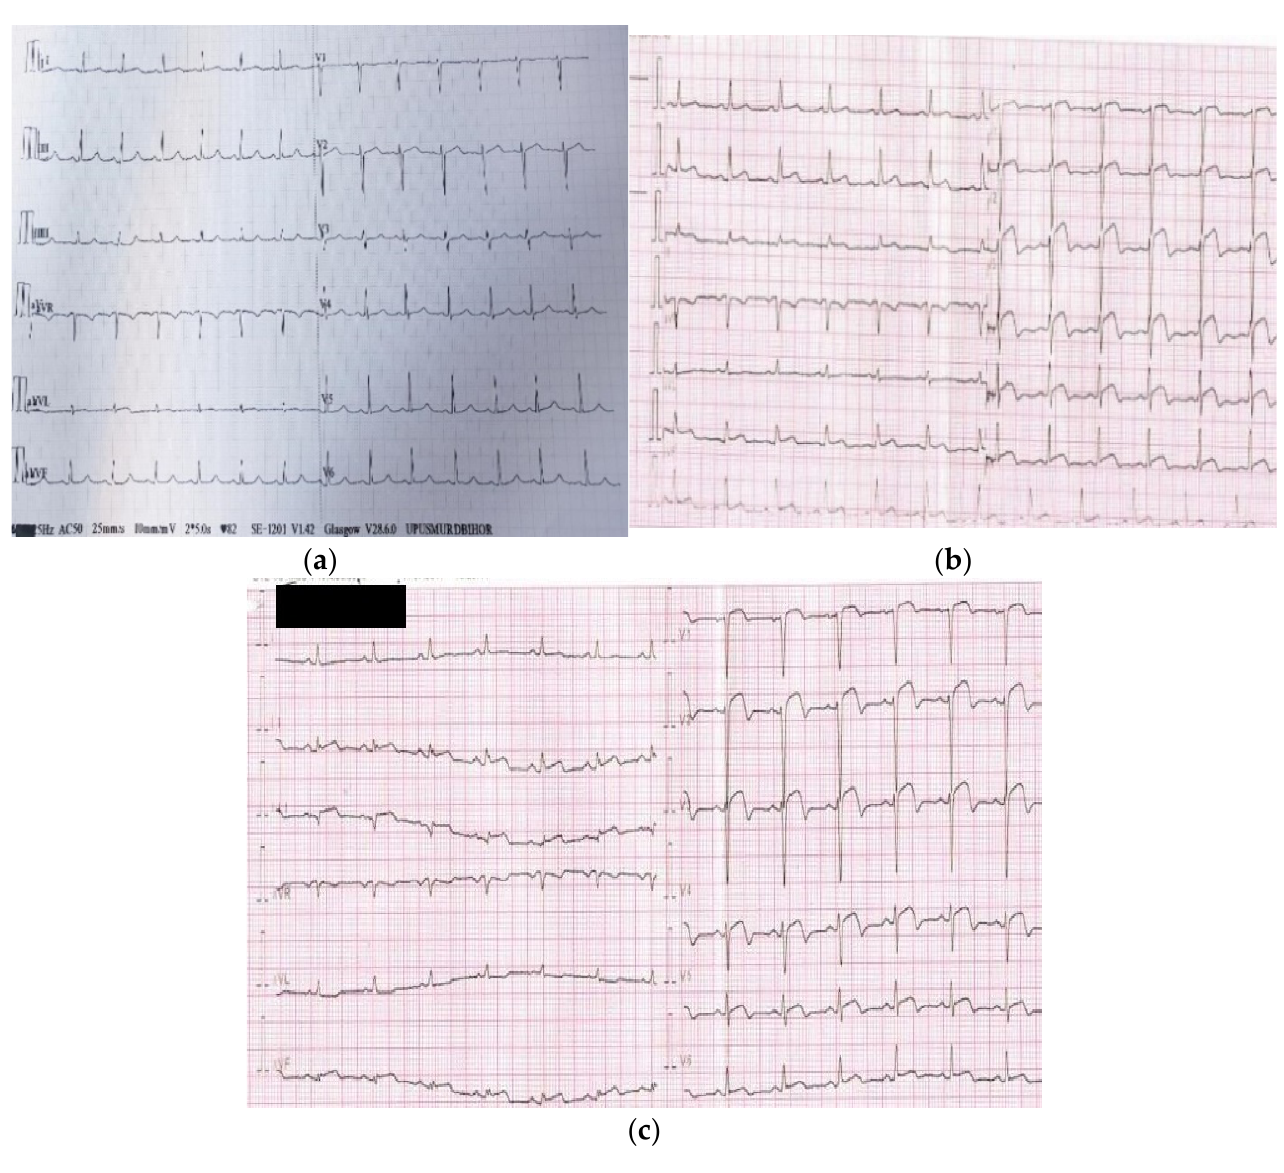
Figure 4. Characteristic aspects of no-reflow phenomenon diagnosis based on ECG: ( a ) normal ECG without ST segment changes (isoelectric); ( b ) ECG in a subject diagnosed with STEMI at admission showing anterior ST segment elevation of 6 mm (precordial leads V1-V6); ( c ) the same patient from ( b )—ECG at 2 h after PPCI of the culprit lesion showing persistent ST segment elevation of 5–6 mm (precordial leads V1-V6) without expected ST segment resolution of more than